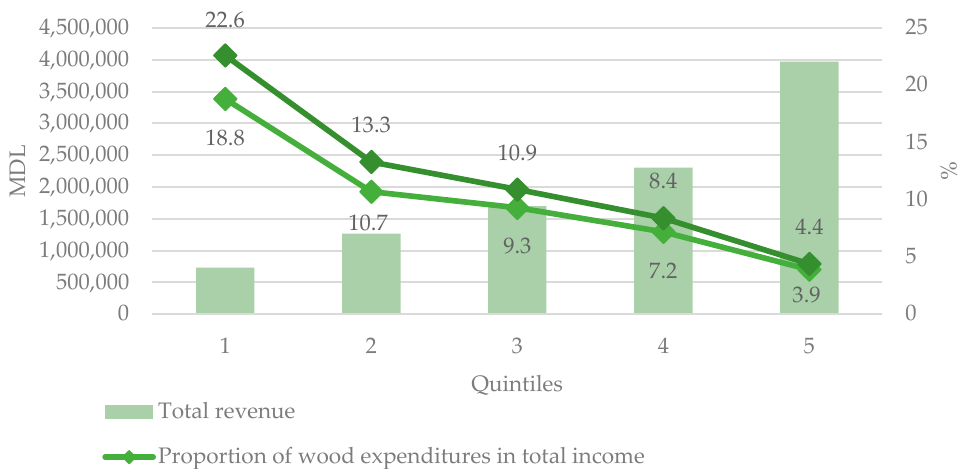
Figure 5. Dependence on forest (collected plus procured products) and proportion of expenditure on procured products (wood) in total income by income quintile (expenses on wood and forest products value are associated with percent scale on the right).